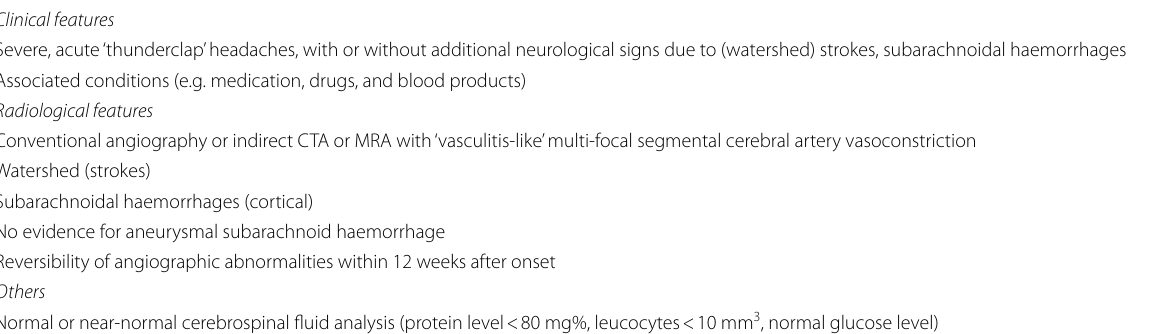
CTA, computed tomographic angiography; MRA, magnetic resonance angiography